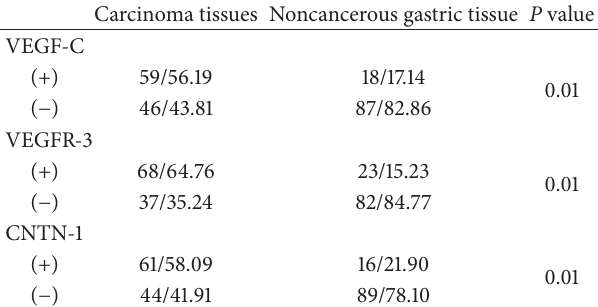
Table 1: The positive rate comparison between experimental group and control group ( 𝑛